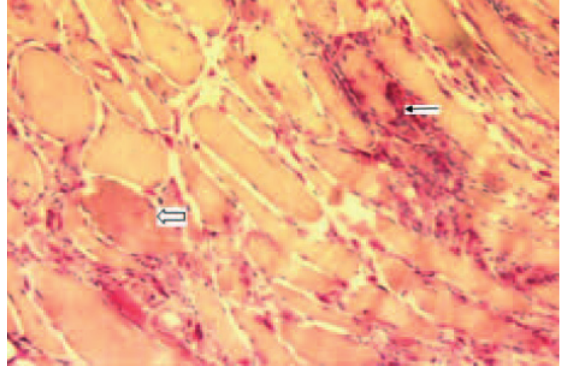
Figure 4. Histological picture of IBM. Overexpression of acid- phosphatase is the sign of intense lysosomal activity associated to infl ammation, both in the infl ammatory cells (white arrow) and in the muscle fi bers (black arrow). (Acid phosphatase;